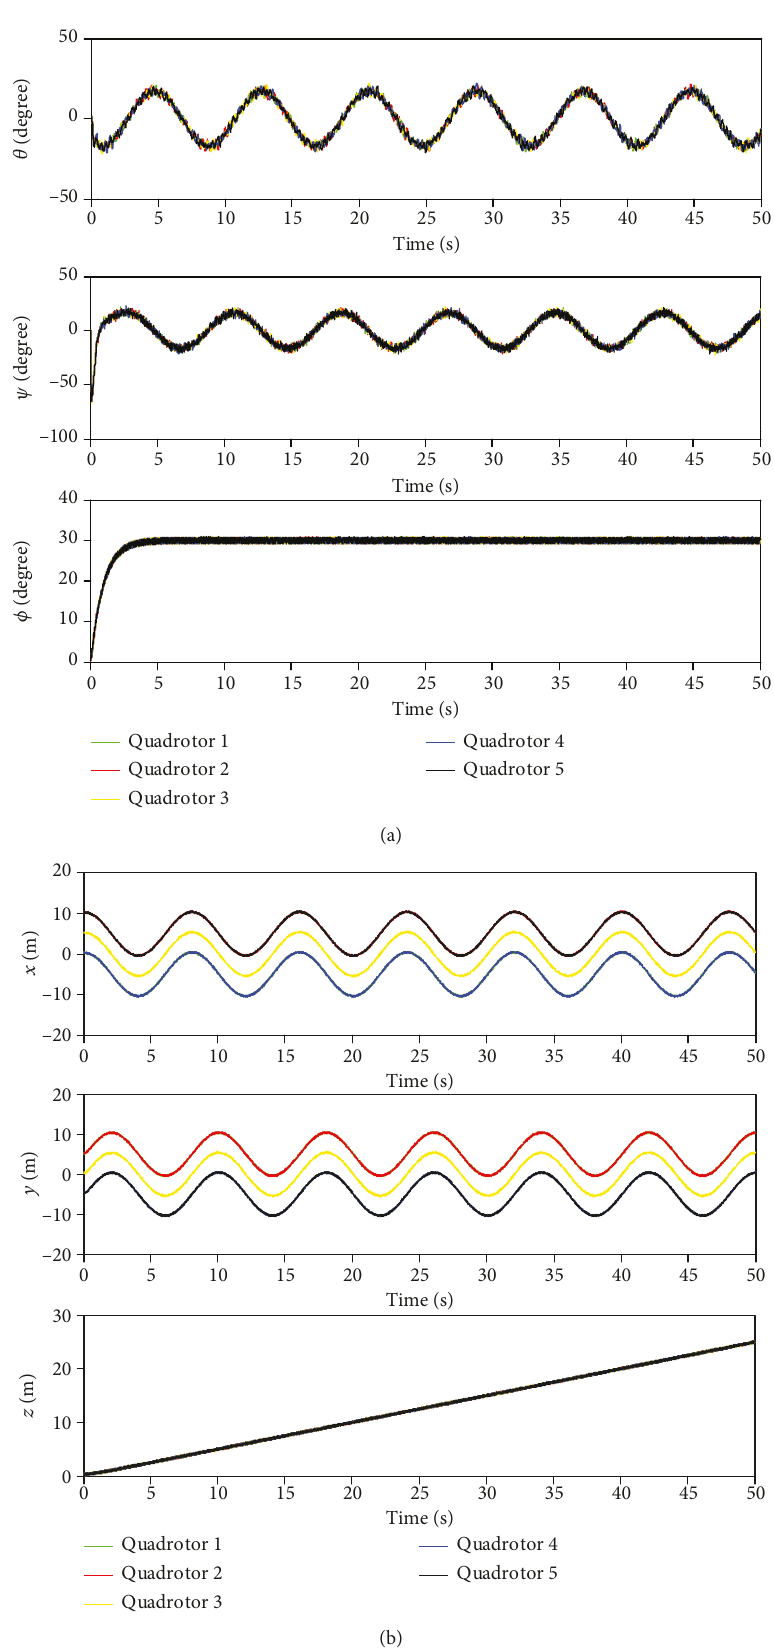
Figure 13: Flight process: (a) the variation of attitudes; (b) the variation of